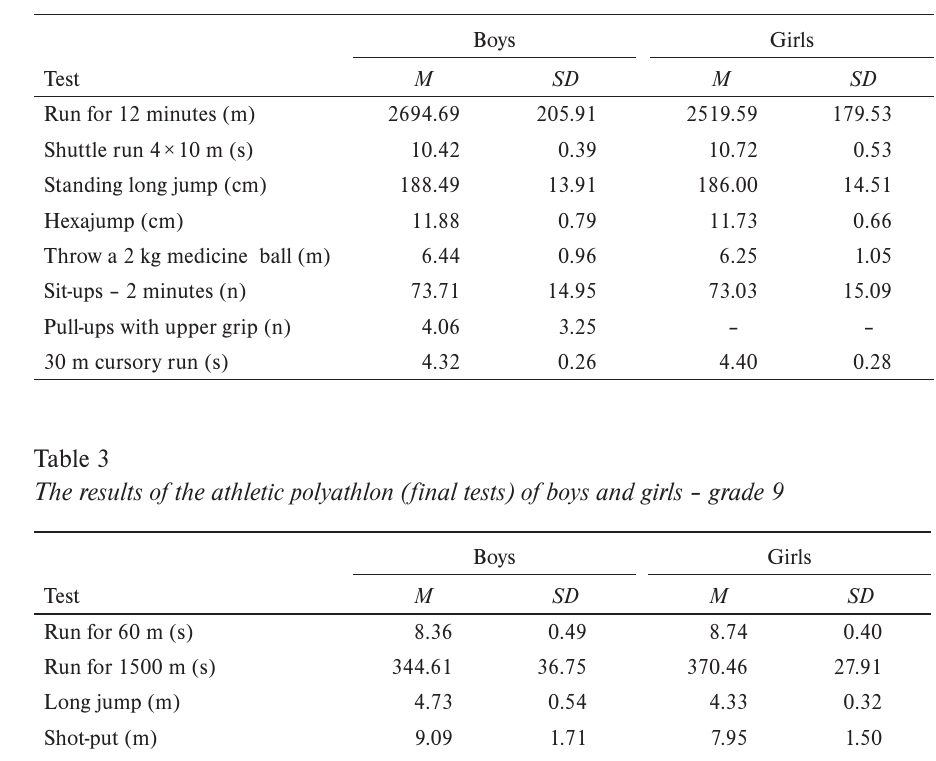
The results of entrance motor tests of boys and girls – grade 6